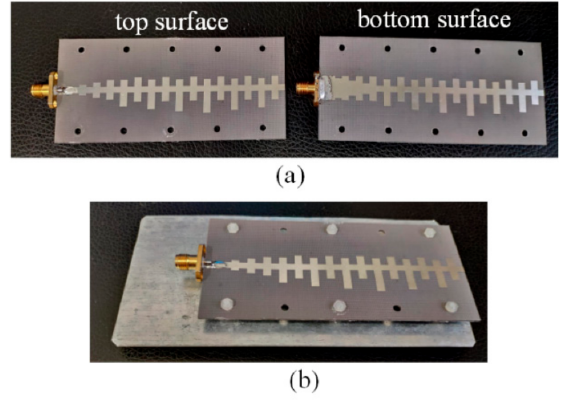
Figure 14. Photos of the proposed antenna. ( a ) top and bottom surfaces, ( b ) full view.